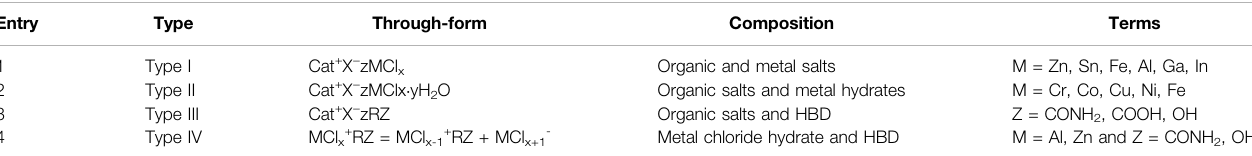
TABLE 1 | The general formula for the classi fi cation of DES. Reprinted from ref. (Smith et al., 2014). Copyright 2014 American Chemical